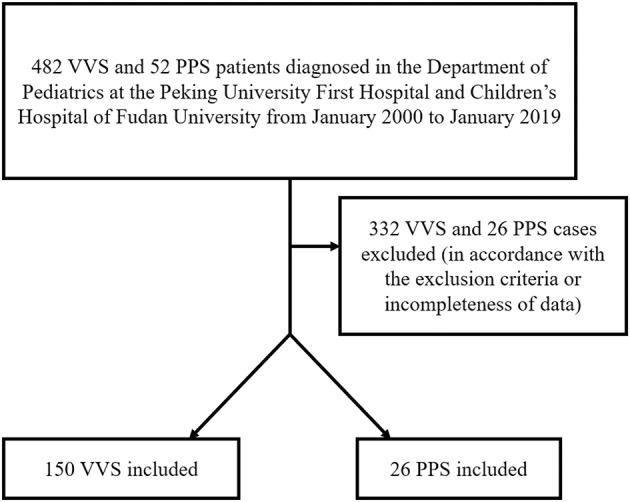
Flow chart of enrollment of study population in the first part of the study. PPS, psychogenic pseudosyncope; VVS, vasovagal syncope.